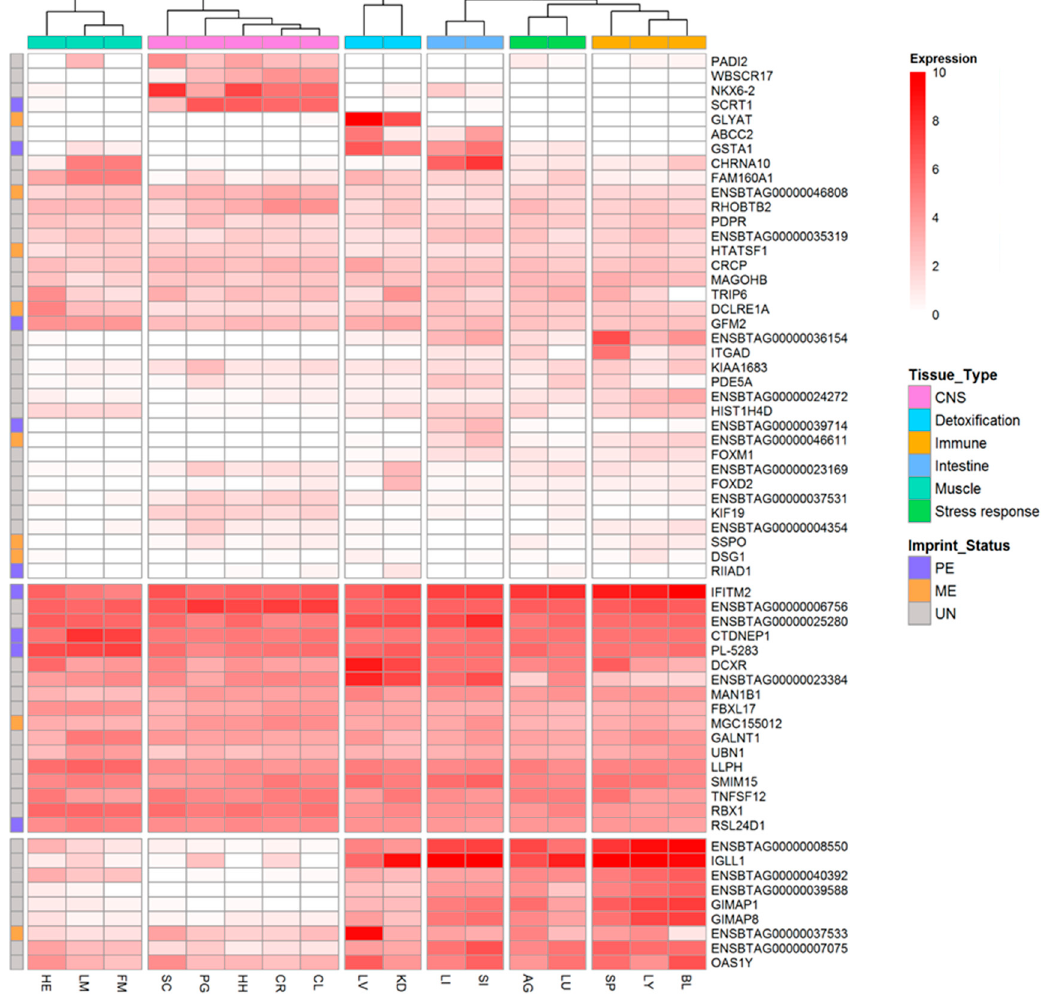
Figure 2. The expressions and imprinting status of monoallelically expressed genes in all tested tissues. Red color scale represents log2(median FPKM + 1). The values above 10 were represented to 10, which means the gene expression is very high in the tissue. FPKM, fragments per Kilobase of exon per million fragments mapped; CNS, central nervous system; PE, paternal expression; ME, maternal expression; UN, unknown;.